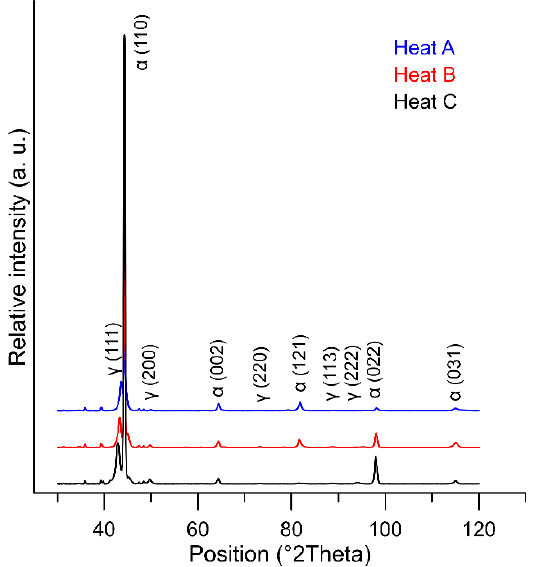
Figure 15. Pearlitic islands at the boundaries of the original austenitic grains formed during cooling at 50 °C s − 1 . P—pearlite, δ —ferrite, M—martensite, RA—retained austenite.